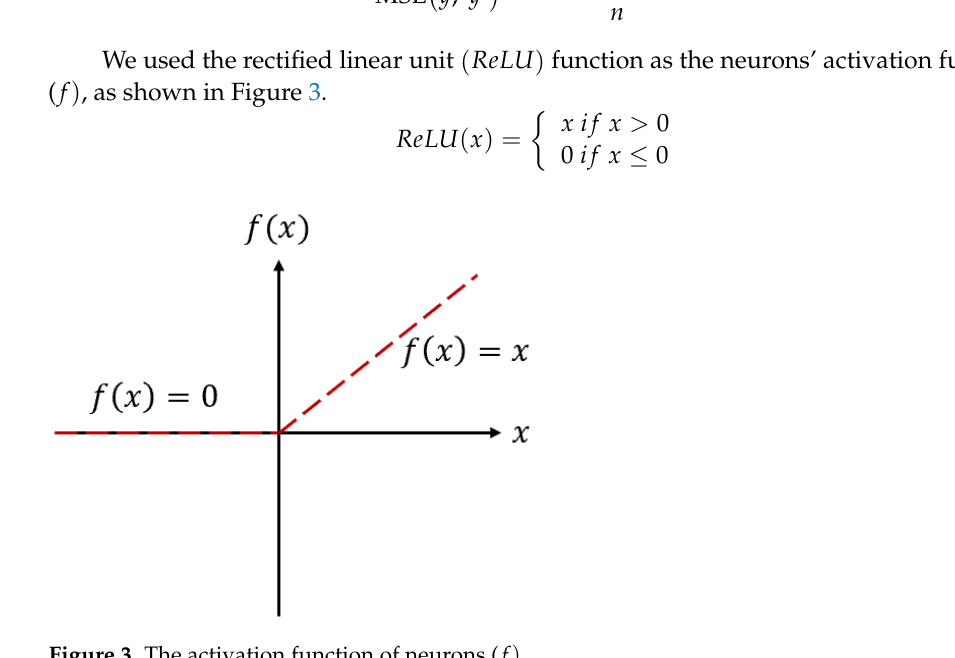
8 of 18 Figure 2. Structure of an ANN neural network.